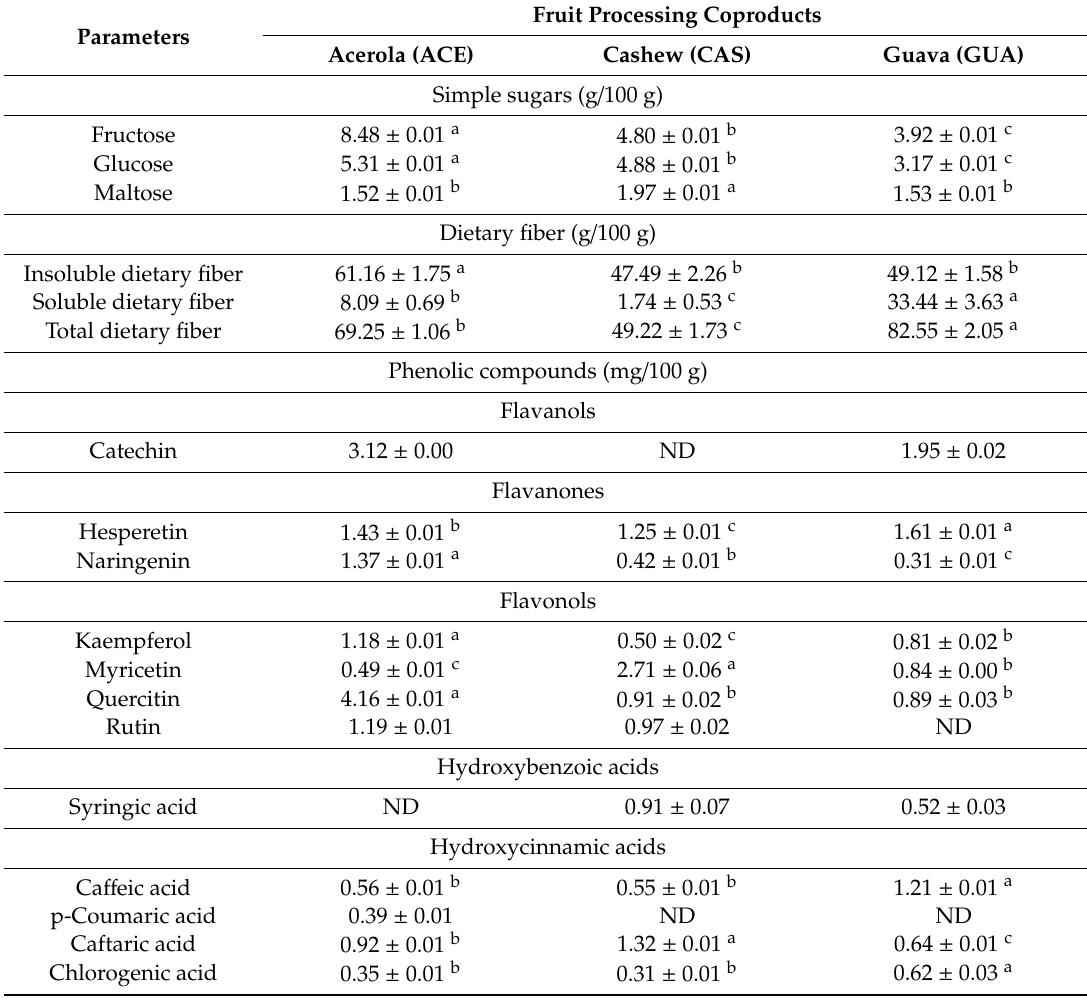
Table 1. Physicochemical characteristics (mean ± standard deviation) of freeze-dried fruit processing coproducts used in assays of protective e ff ect on probiotic Lactobacillus